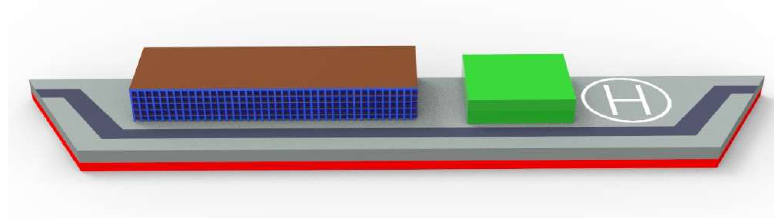
Figure 1. Schematic diagram of full scale structure.